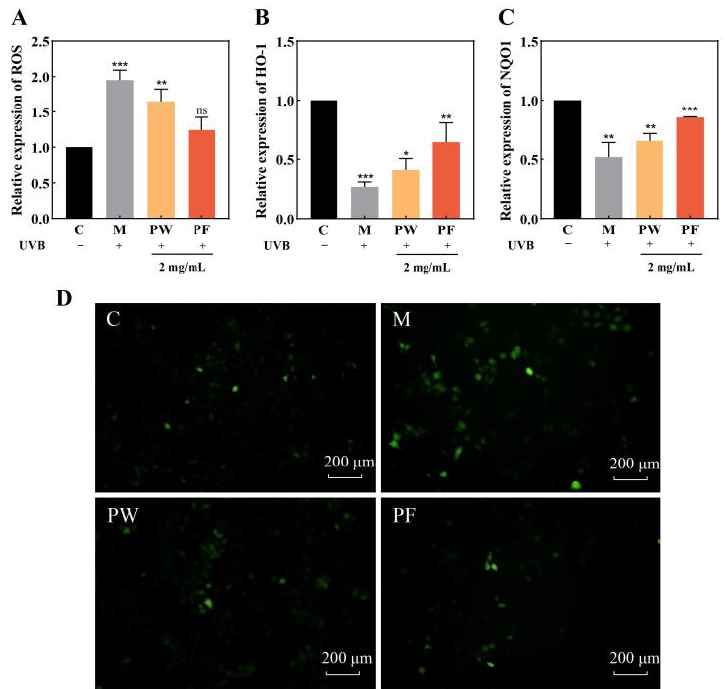
Figure 5. Effects of PF and PW on the activity of ROS, antioxidant enzymes and detoxification enzymes in HaCaT cells. ( A ): Cell fluorescence intensity value. ( B ): Effects of 2 mg/mL PF and PW on activity of HO-1 antioxidant enzymes in HaCaT cells. ( C ): Effects of 2 mg/mL PF and PW on activity of NQO1 detoxification enzymes in HaCaT cells. ( D ): Cell ROS fluorescence intensity. PW: Passiflora edulis Sims peel water extract. PF: Passiflora edulis Sims peel fermentation broth. C: control group. M: UVB damage model group. Each value is expressed as mean ± SD ( n = 3). (*: p < 0.05, **: p < 0.01, ***: p < 0.001, ns > 0.05, versus control group).